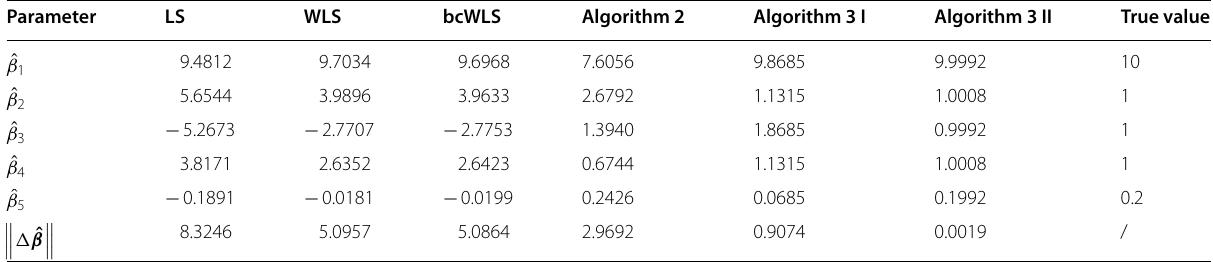
Table 5 Parameter estimates and the 2-norm results between the parameter estimates and true values for the second example Parameter LS WLS